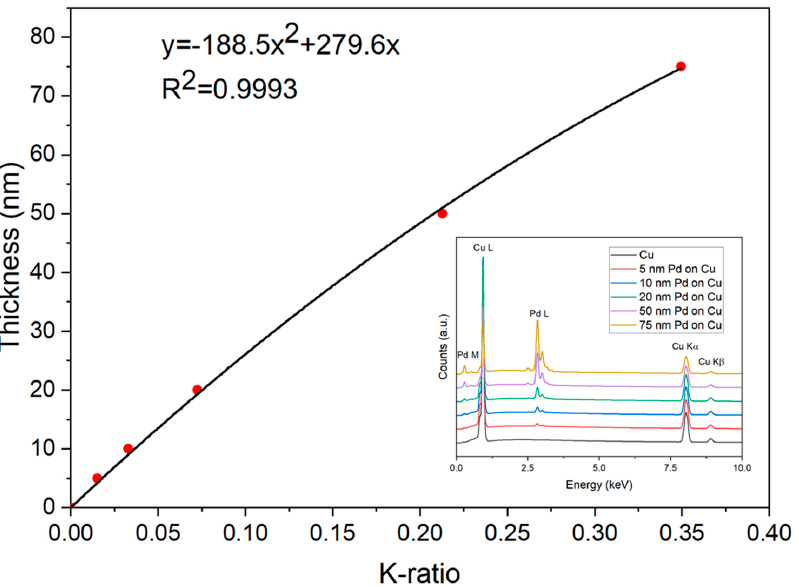
Figure 2. Fitting curve of simulated standard palladium film thicknesses and relative K-ratio. The fitting equation and the R 2 value of the fitting equation are reported in the figure. The inset shows the simulated spectra used to obtain the K-ratios.